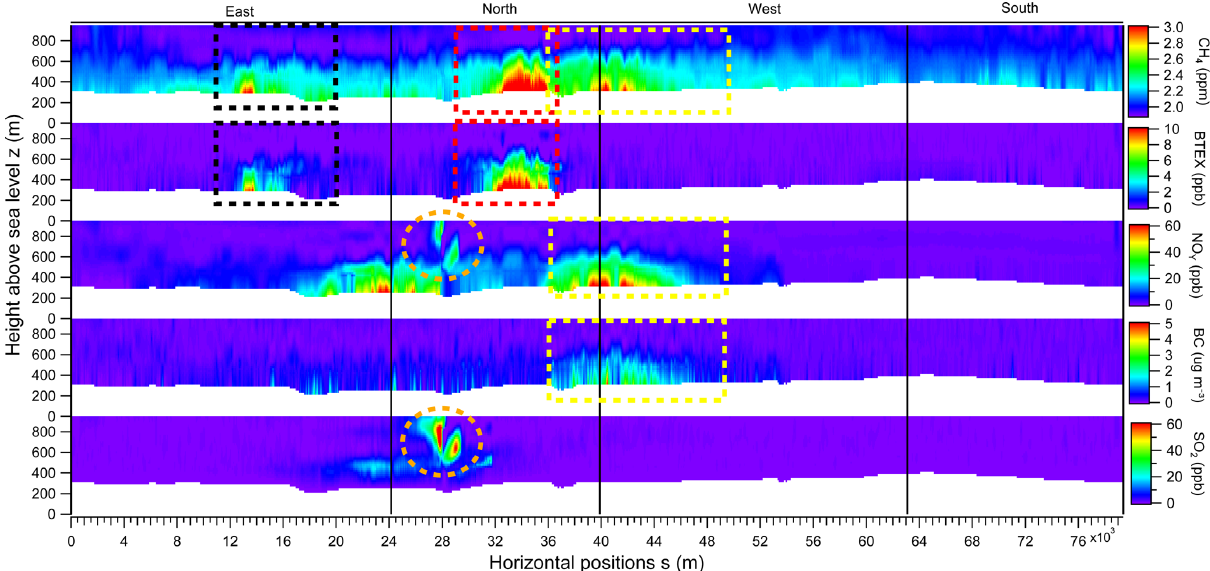
Figure 5. Curtain plots showing interpolated CH 4 , BTEX, NO y , r BC and SO 2 mixing ratios for the 14 August box flight around SML. The red-dashed box indicates the primary plume on the north screen, the yellow-dashed box indicates the secondary plume on the west screen and the black-dashed box indicates the tertiary incoming plume on the east screen. The orange dashed-circle shows the upgrader plume on the north